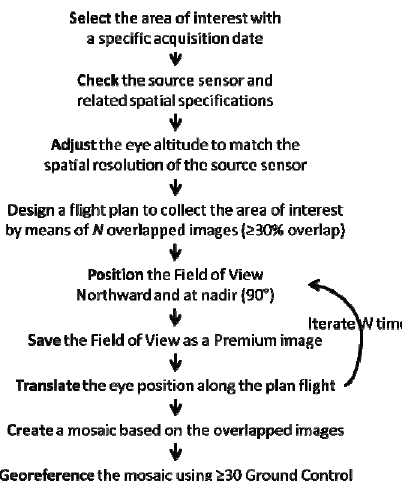
Figure 2. Conceptual flowchart describing the successive steps enabling a Google Earth-derived very high resolution mosaic to be